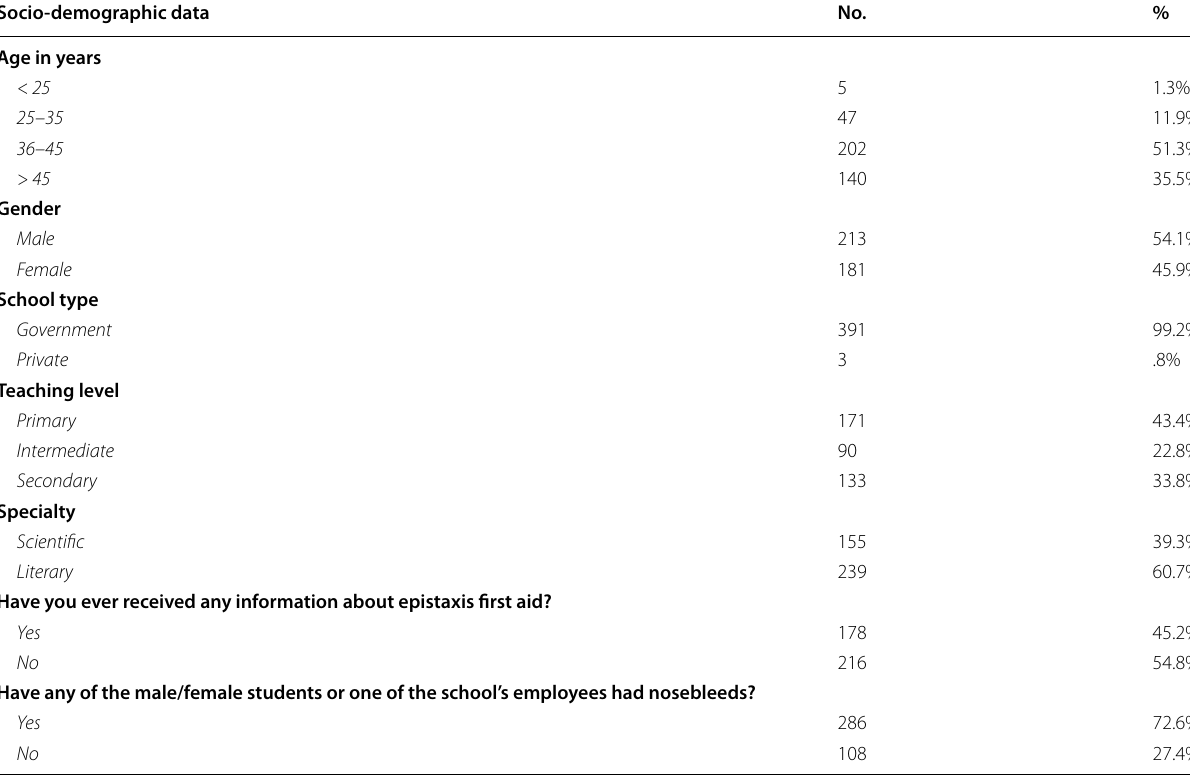
Table 1 Socio‑demographic data of the participant teachers in Aseer Region, Saudi Arabia Socio-demographic